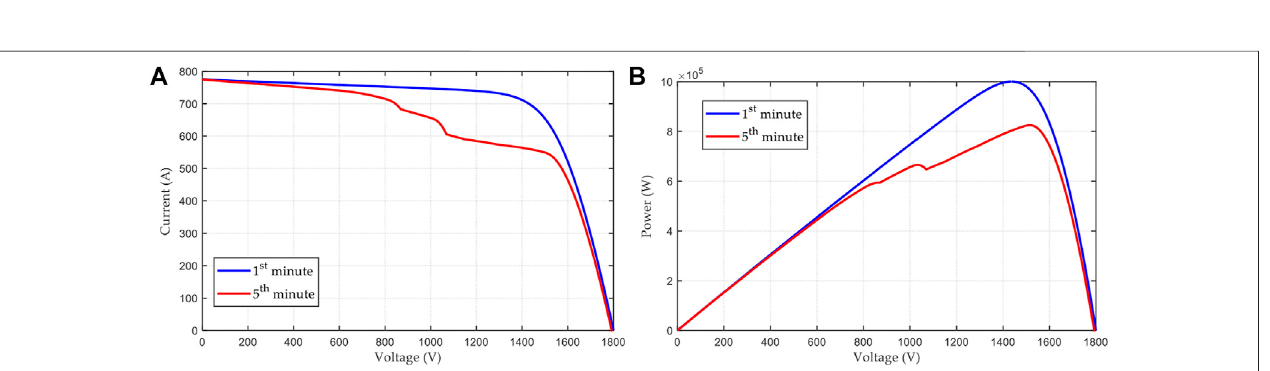
FIGURE 5 | Output feature of each sub-system at the 1st and 5th minutes. (A) I – V curve and (B) P – V curve.